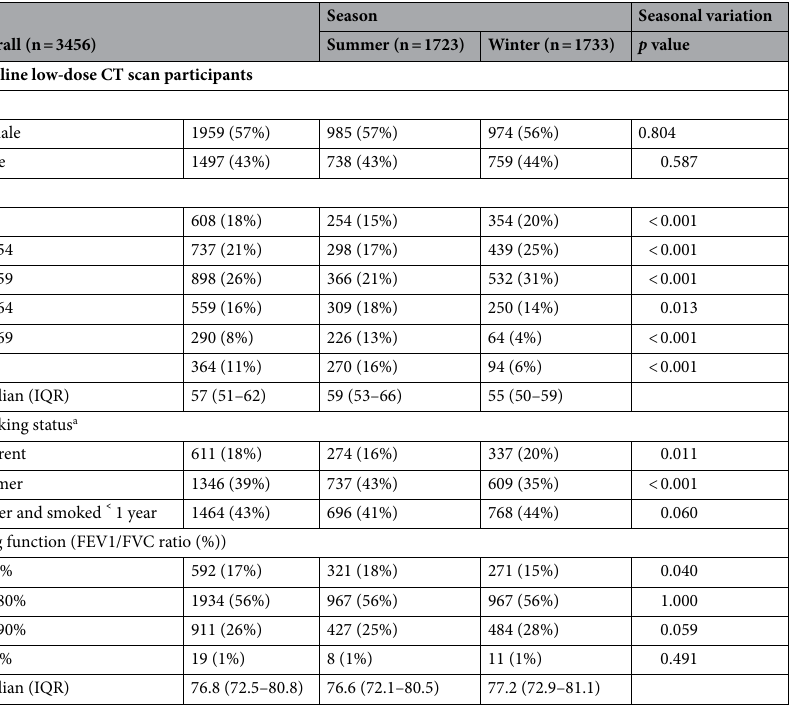
Table 1. Population characteristics. N total number, IQR inter quartile range, FEV1 forced expiratory volume in 1 s, FVC forced vital capacity. a Smoking status information missing for 35